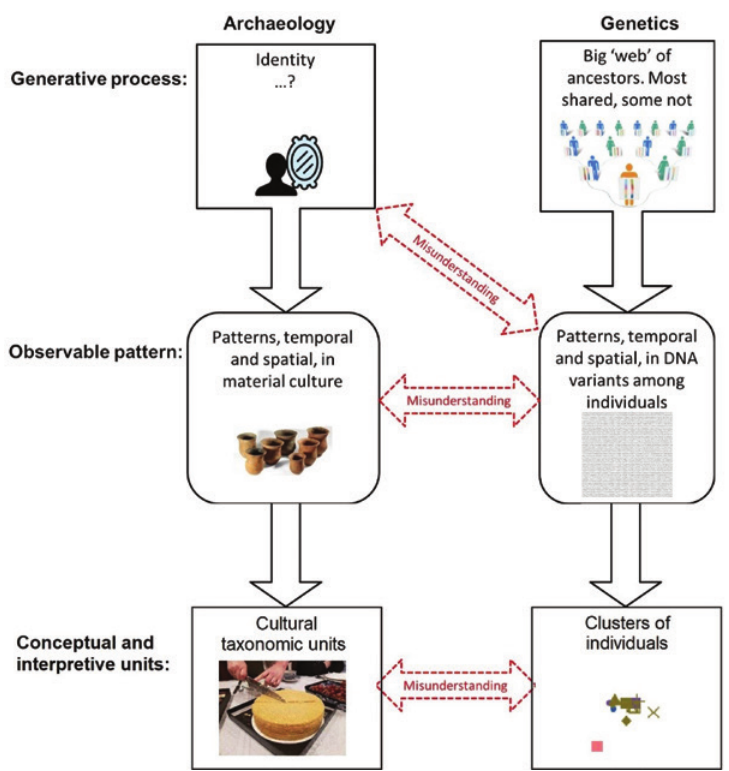
Figure 4 Interactions between archaeology and genetics. (Image credit: Pontus Skoglund and Natasha